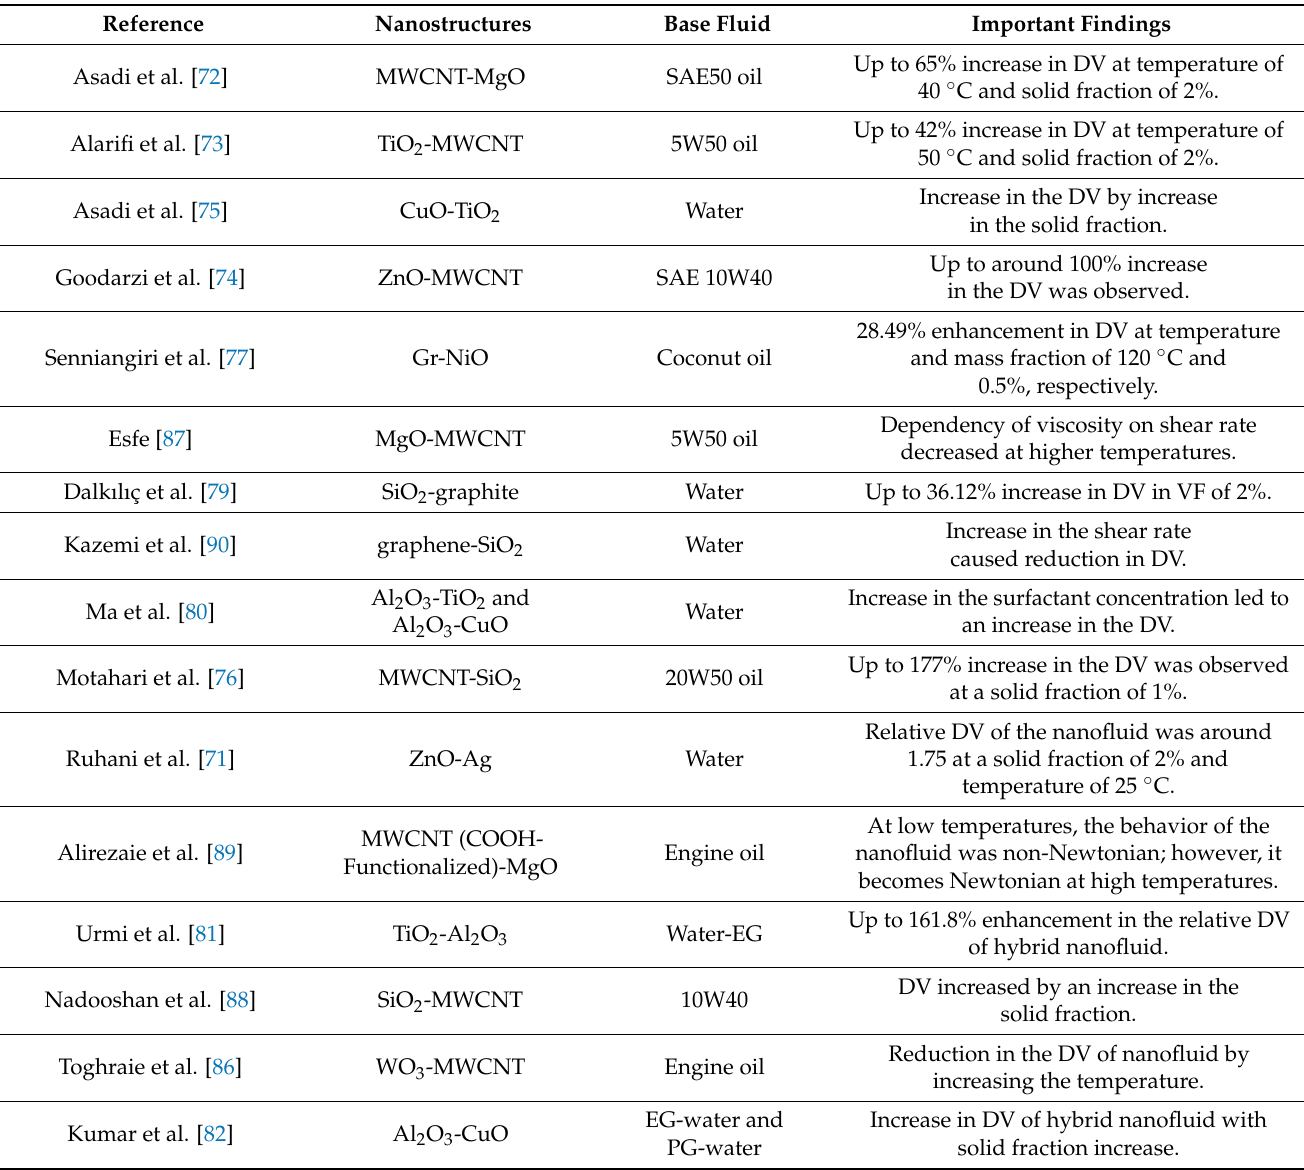
Table 5. Findings of the works on the DV of hybrid